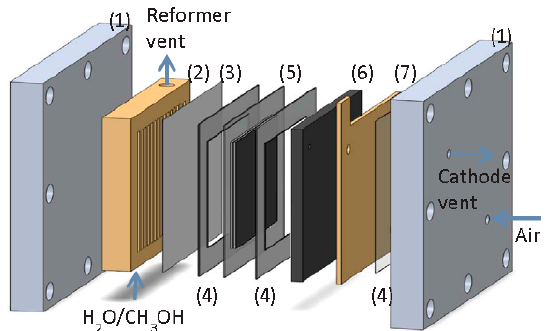
Figure 15. Schematic representation of the integrated system (MR + high temperature polymer electrolyte fuel cell (HT-PEMFC)): two metal endplates frames (1), gold coated reformer (2), Pd-Ag membrane (3), gasket (4), MEA (5), graphite composite bipolar plate (6) and current collector (7). With permission of reprint of Elsevier from Ribeirinha et al. [63].